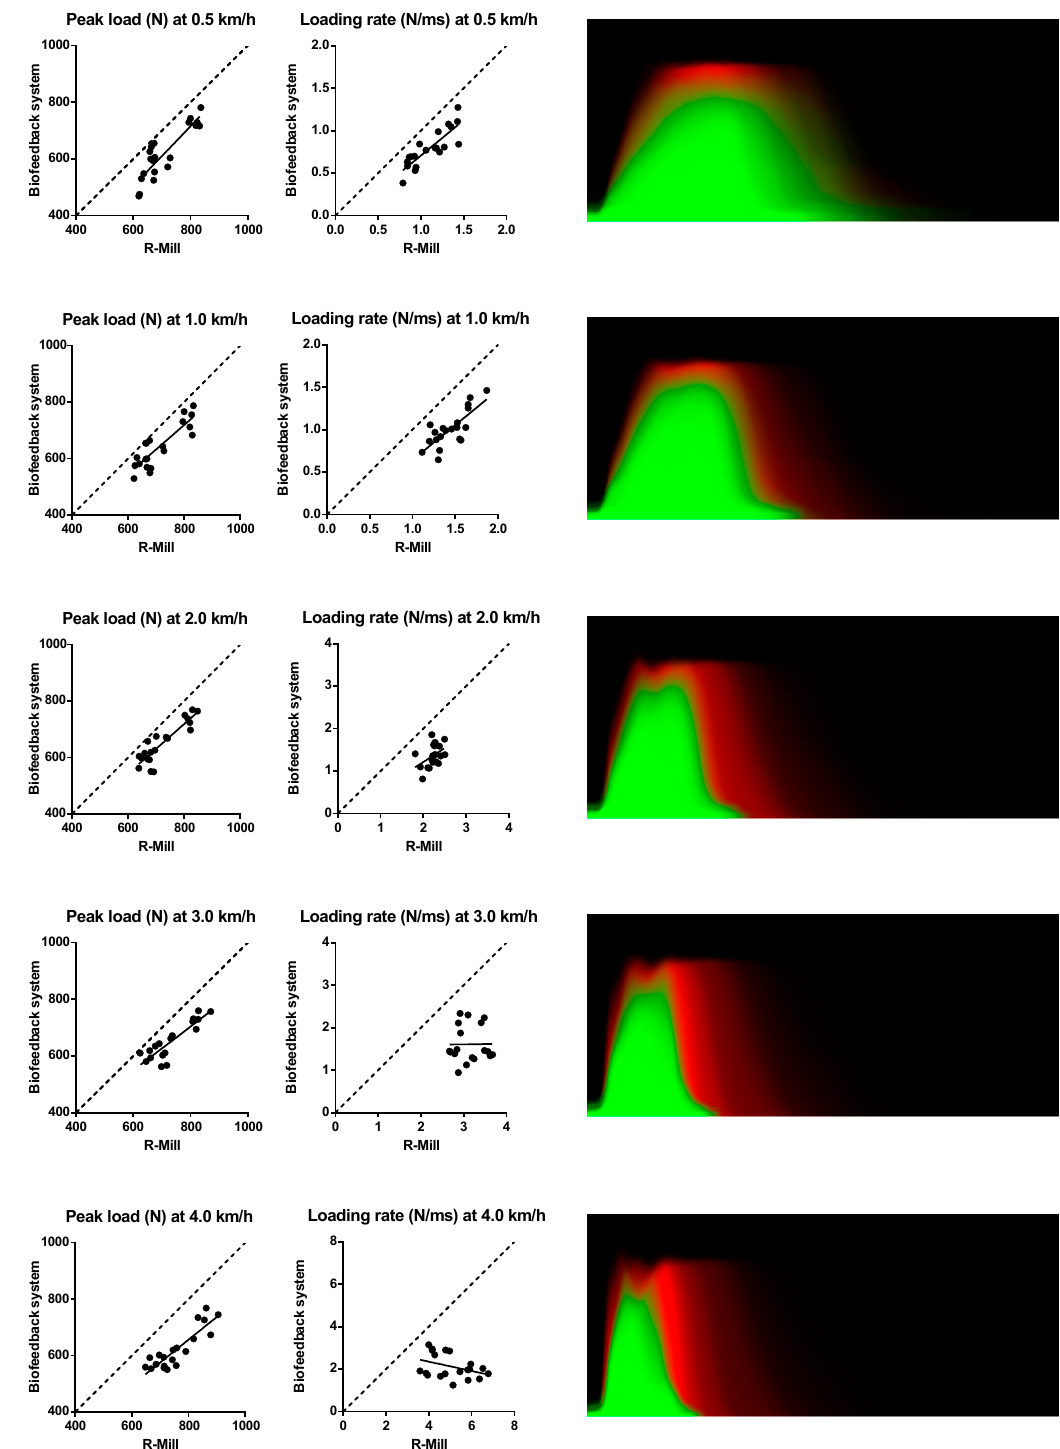
Figure 5. Validation of the biofeedback system in the dynamic situation at different speeds. Left : peak load (N) measured by the R-Mill vs. peak load (N) measured by the biofeedback system. Middle: loading rate (N/ms) measured by the R-Mill vs. loading rate (N/ms) measured by the biofeedback system. Right : overlay of the load curves (n = 10) measured by the R-Mill (red) and the biofeedback system (green). Legend: - - - Linear curve, Observed curve, R-Mill vs. biofeedback system.